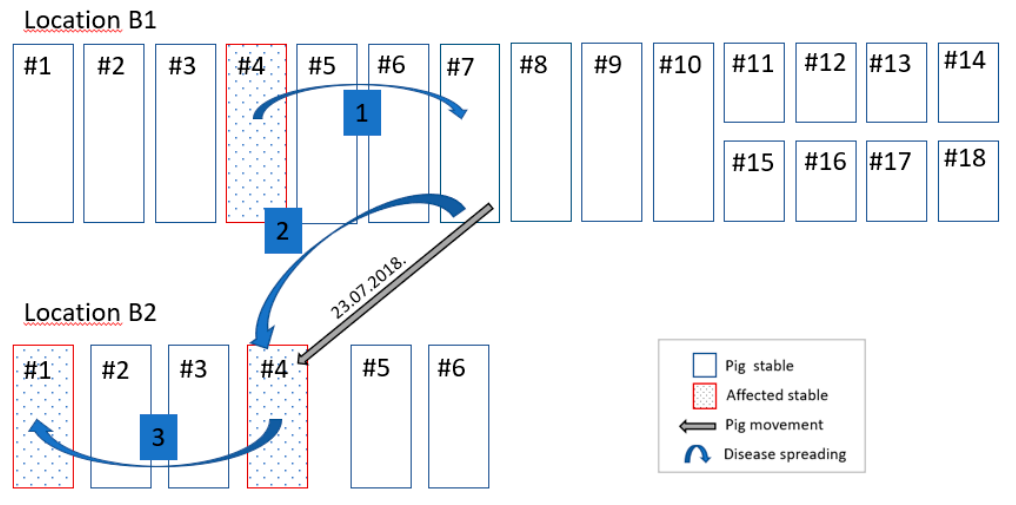
Figure 5. Potential spreading of ASF virus between the stables in a Farm B.